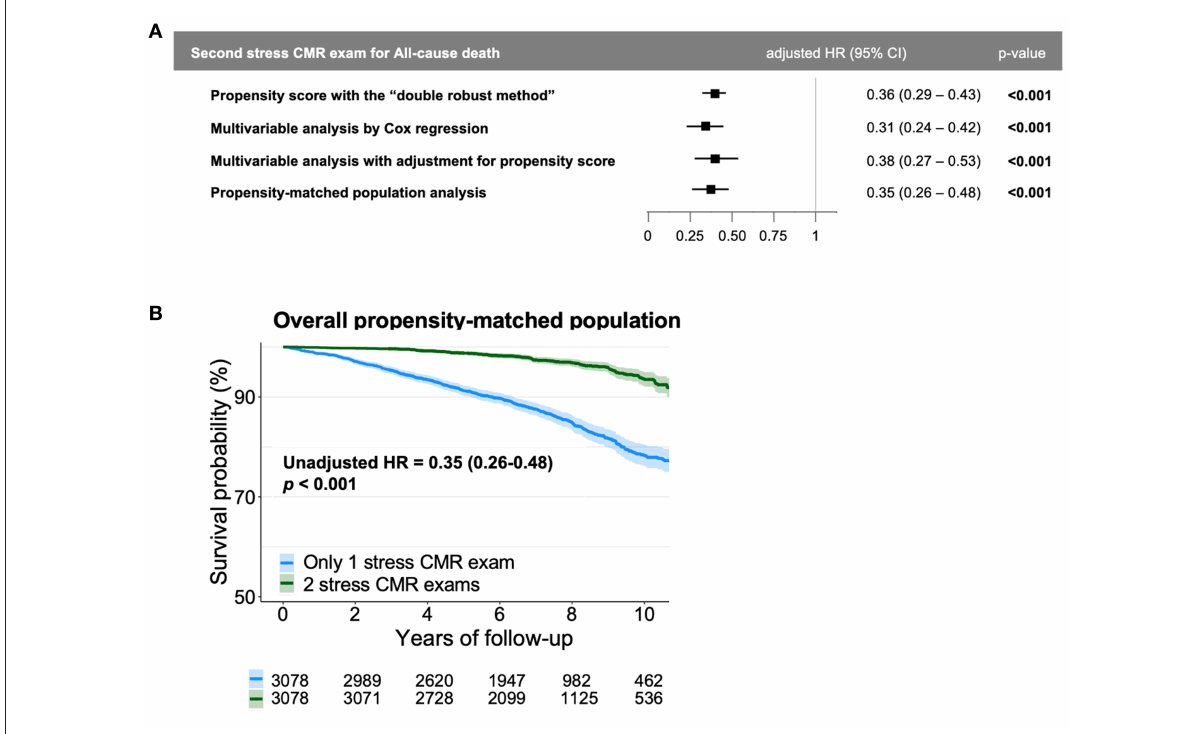
FIGURE1 Impact of a second stress CMR study on mortality. (A) Forest plots with adjusted hazard ratio for the occurrence of death according to presence/absence of a second stress CMR study. (B) Kaplan-Meier curves of all-cause death as a function of follow-up stratified by presence/absence of a second stress CMR study in the propensity-matched